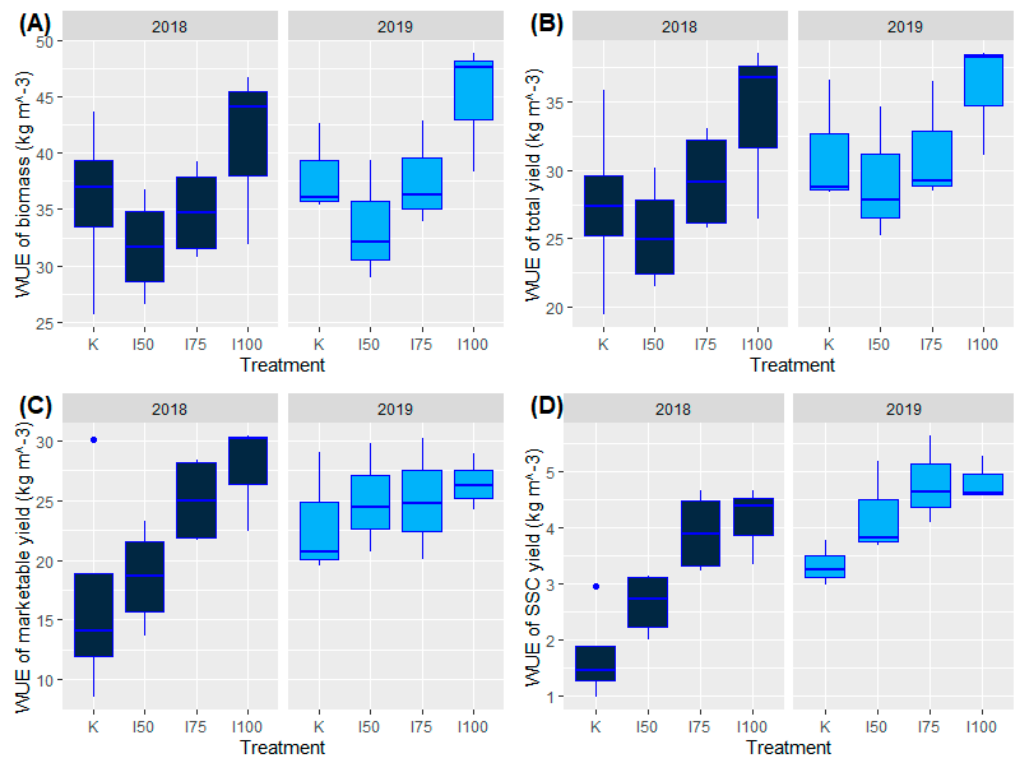
Figure 3. The effect of different water supply treatments in both years on the water use efficiency, calculated for full biomass ( A ), the total yield ( B ), the marketable yield ( C ), and the soluble solids content (SSC) yield ( D ). No significant difference was found between treatments.